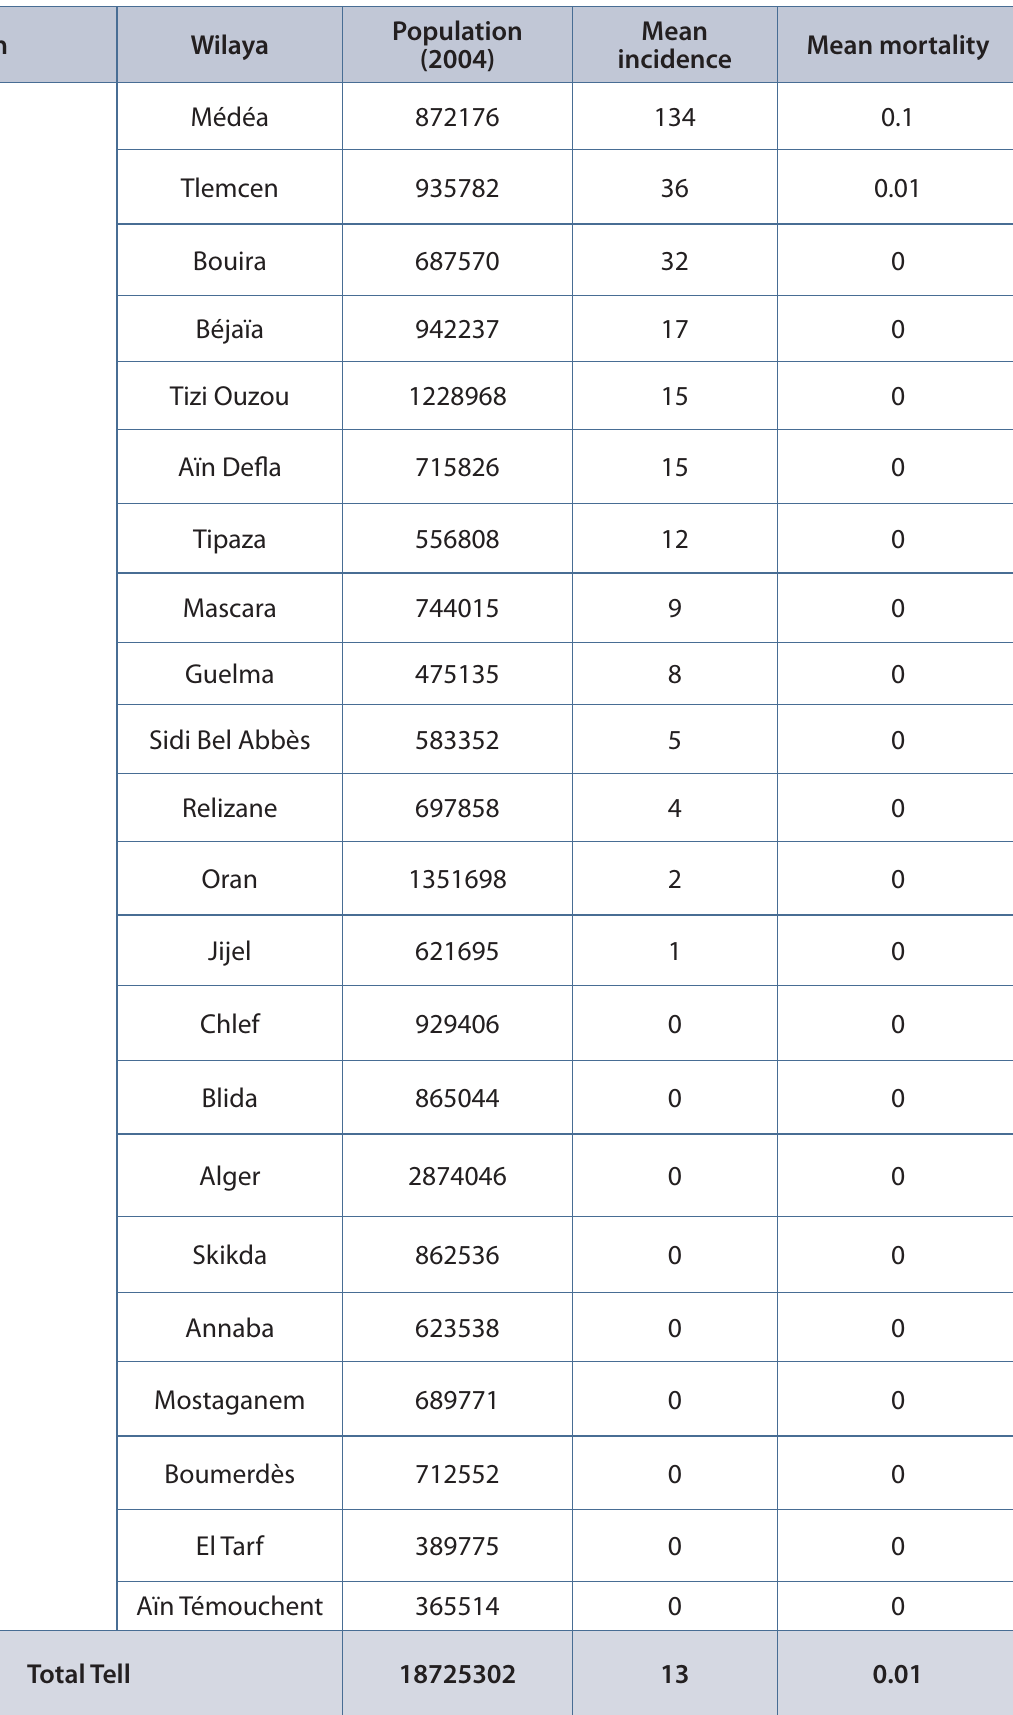
Table 2. Regional incidence and mortality